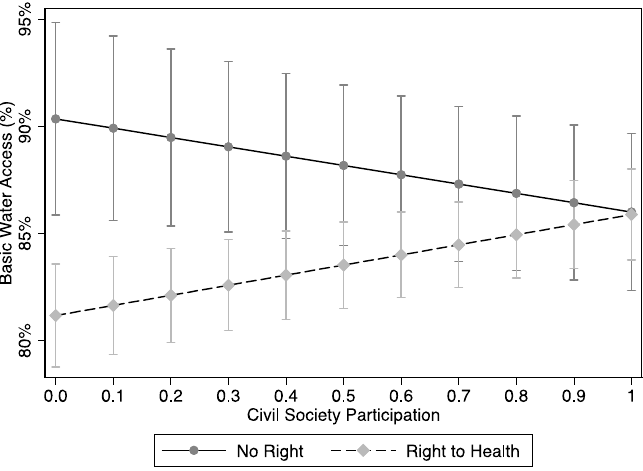
Figure 4. Marginal Effects of Civil Society Participation and Right to Health on Access.